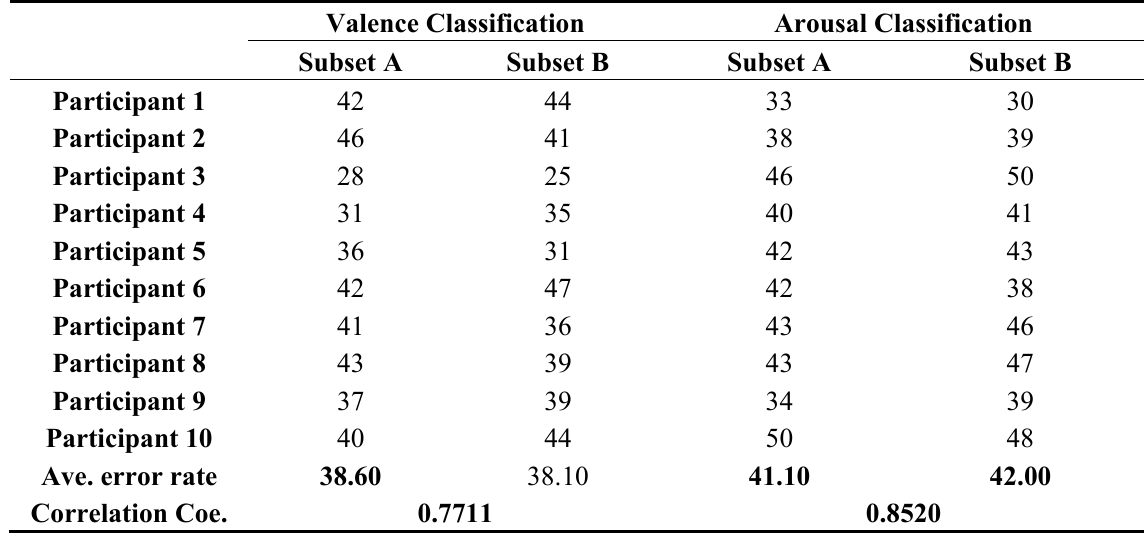
Table 5. Average error rates of the split half procedure (%) using SP feature and k -NN classifier.